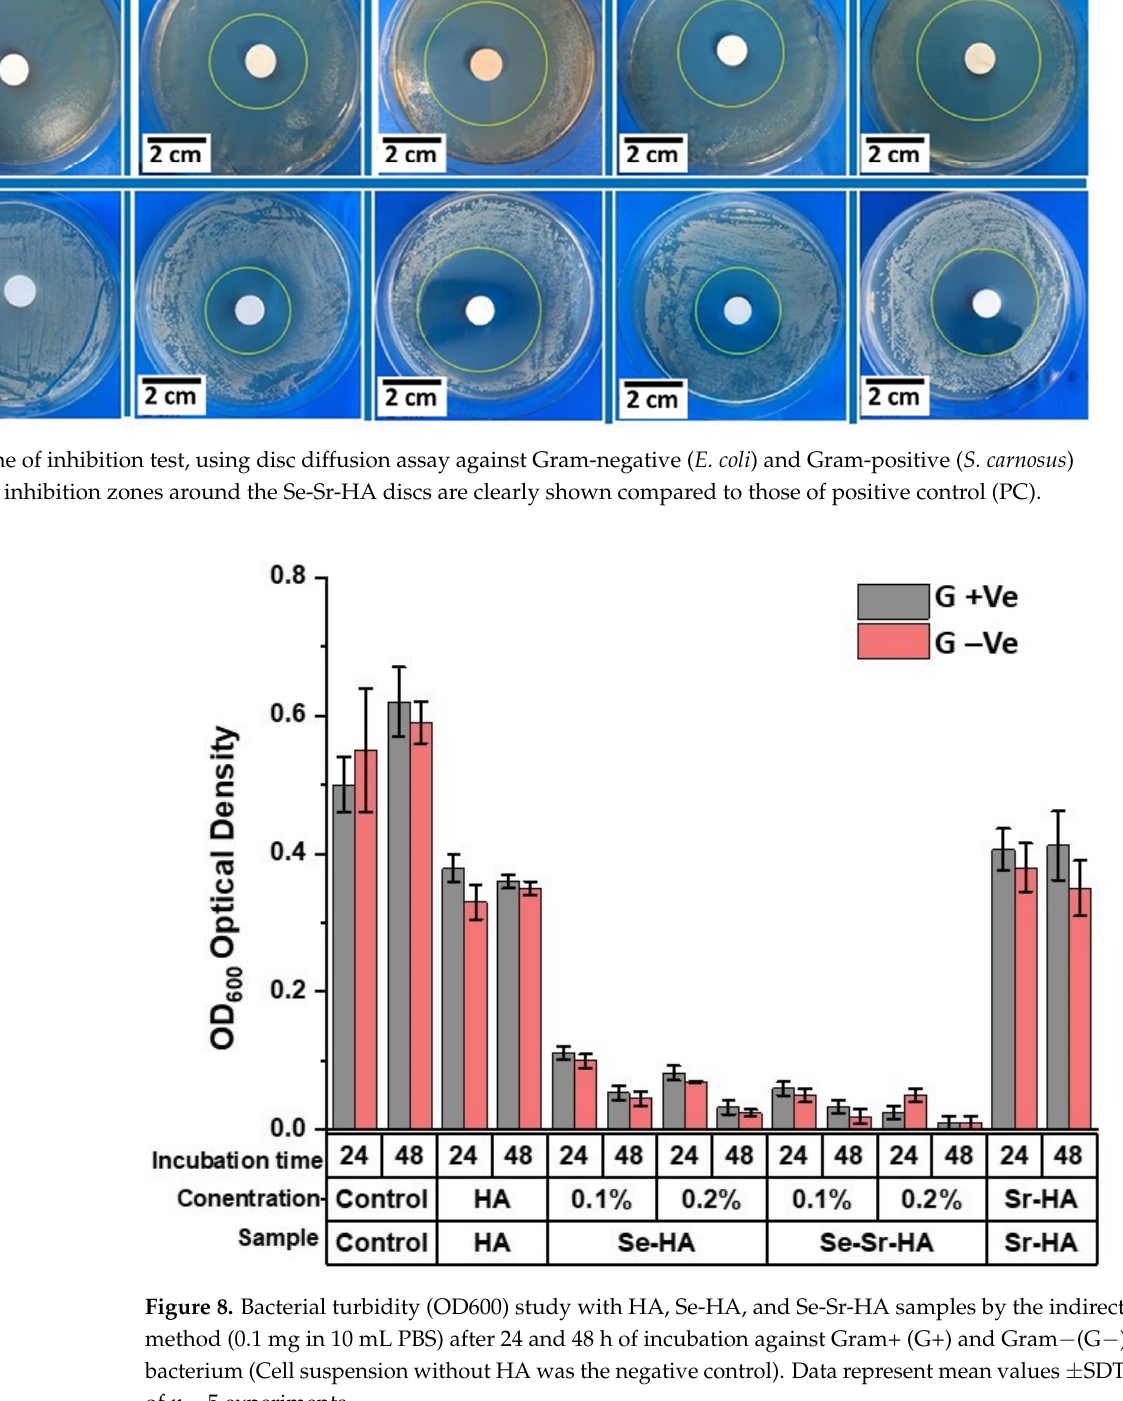
Figure 7. Zone of inhibition test, using disc diffusion assay against Gram-negative ( E. coli ) and Gram-positive ( S. carnosus ) bacteria. The inhibition zones around the Se-Sr-HA discs are clearly shown compared to those of positive control (PC).